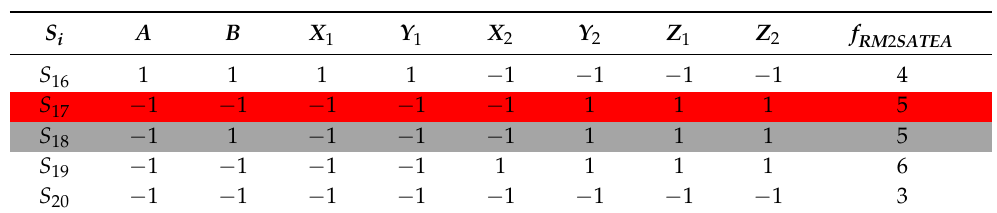
Table A12. Party 4 lost S 18 to Party 2.